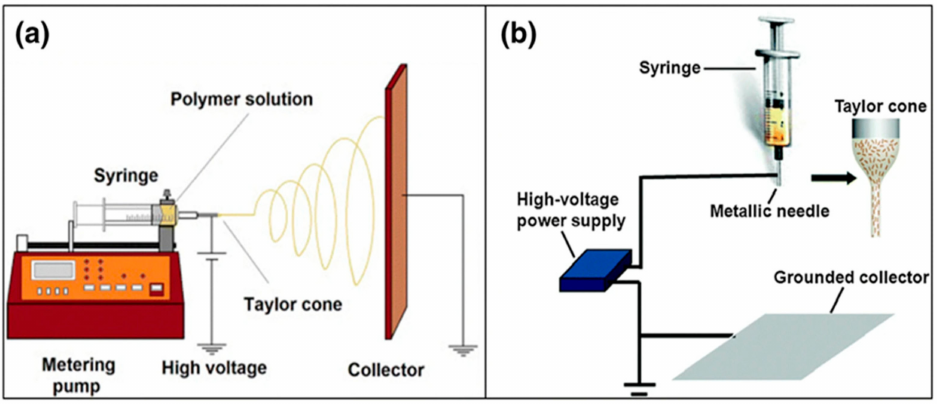
Figure 3. ( a ) HES setup and ( b ) VES setup